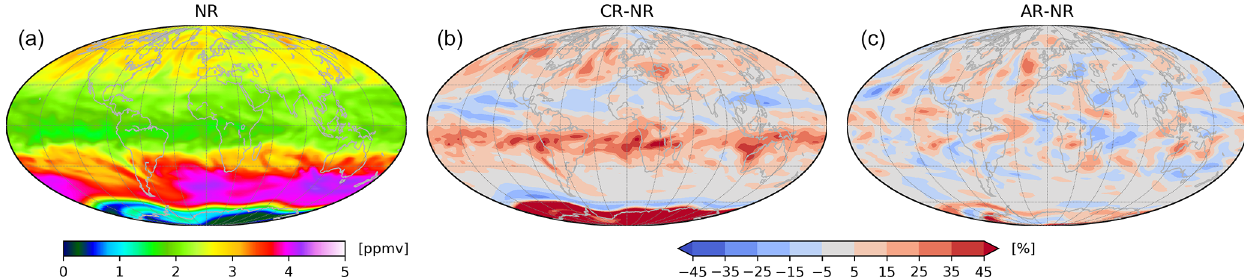
Figure 8. (a) Daily average ozone distribution (ppmv) from NR around 44hPa (i.e. model level 21) on 15 September 2009. (b) The differences between CR and NR normalized by NR (%). (c) As (b) but for AR.